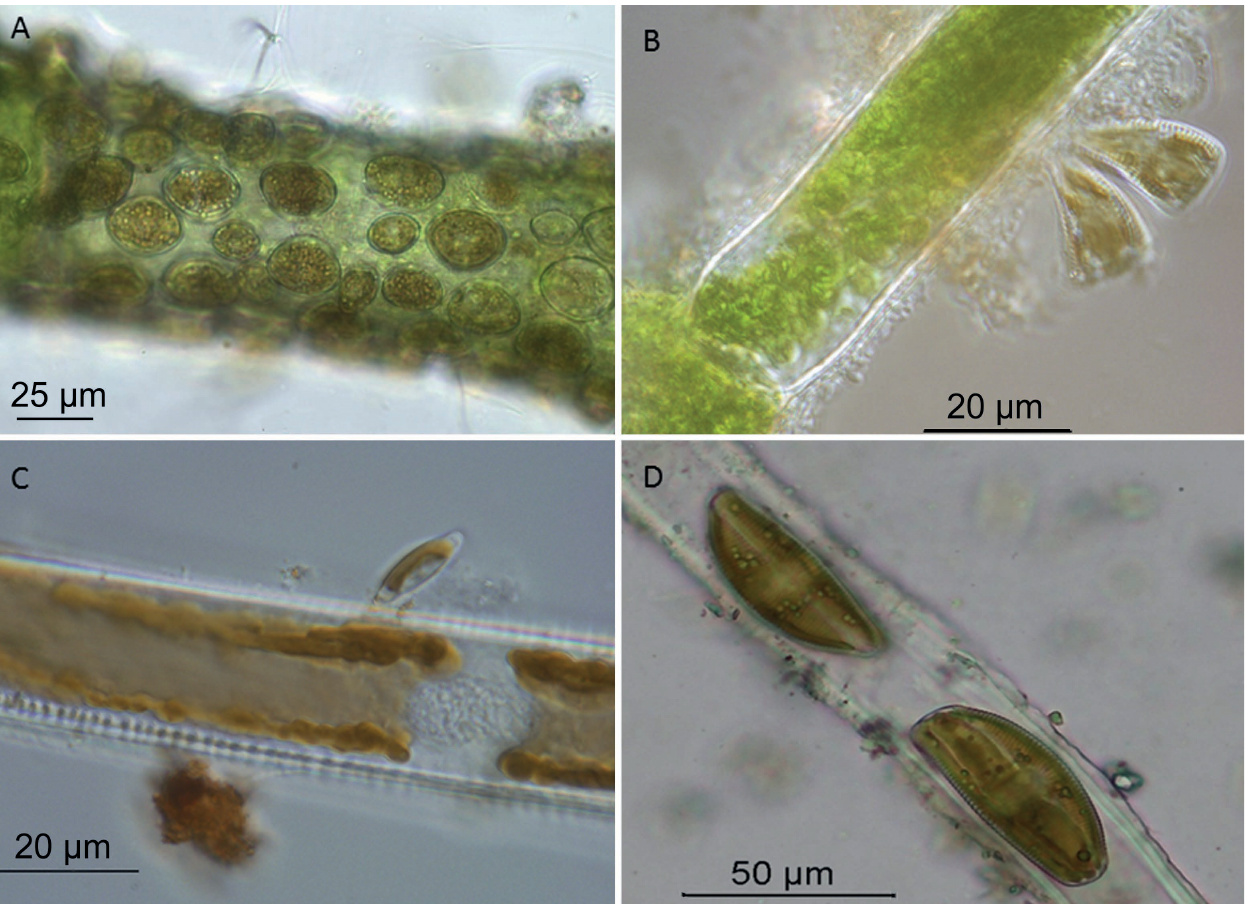
Figure 2 – Digestion of biofilms, necessary for detailed identification, leads to loss of information on host-epiphyte associations; A, closer inspection of live material reveals the presence of diatoms as epiphytes on other freshwater algae e.g. Cocconeis pediculus ; B, Rhoicosphenia abbreviata attached to filaments of green algae; C, diatoms also act as hosts for other diatoms e.g. Achnanthidium minutissimum ; D, removal of other organic material leads to other information loss e.g. presence of tube-dwelling species of diatoms such as Encyonema sp. Samples A & D taken from streams in Baden-Württemberg, Germany; samples B & C taken from Winford Brook, North Somerset,